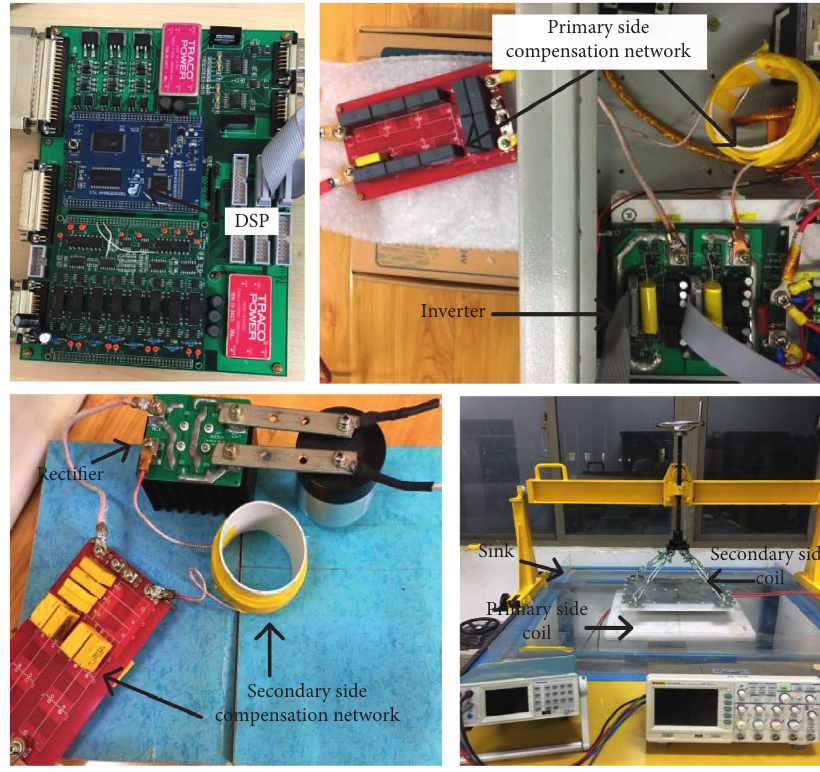
Figure 12: Underwater ICPT experimental platform.